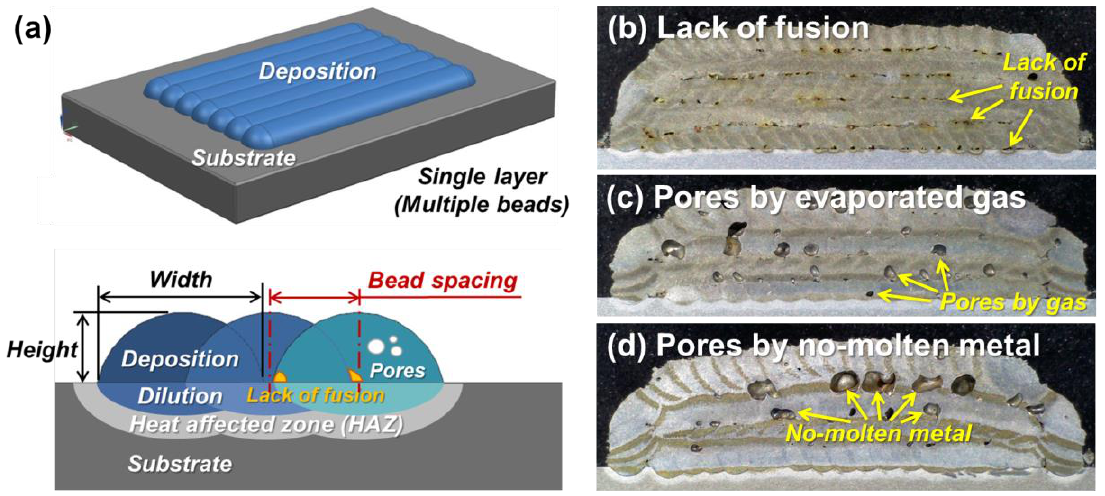
Figure 3. ( a ) Schematics showing the defects (lack of fusion and pores) in the multi-layered deposi- tions. ( b ) A lack of fusion. ( c ) Pores formed by evaporated gas. ( d ) Pores formed by non-molten metal.